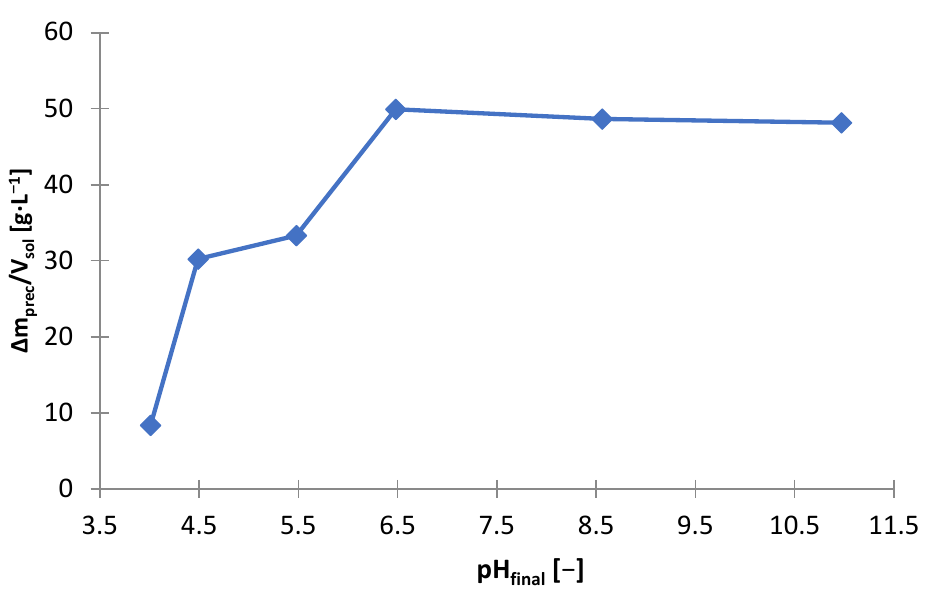
Figure 22. Effect of on final pH (pH final ) on amount of precipitate ( ∆ m prec /V sol ) during precipitation by using Na 3 PO 4 from solution after selective leaching.